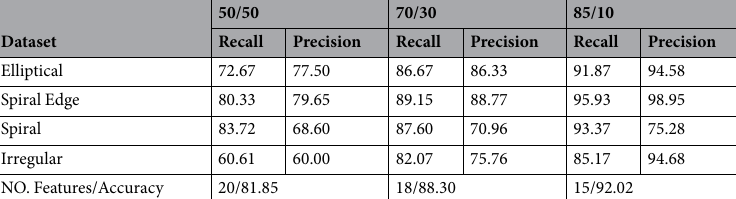
Table 4. The effect of the size of training set on the performance of the proposed approach for galaxy image